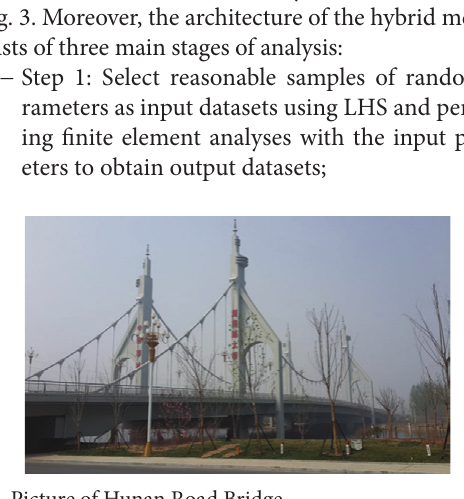
Fig. 4. Picture of Hunan Road Bridge